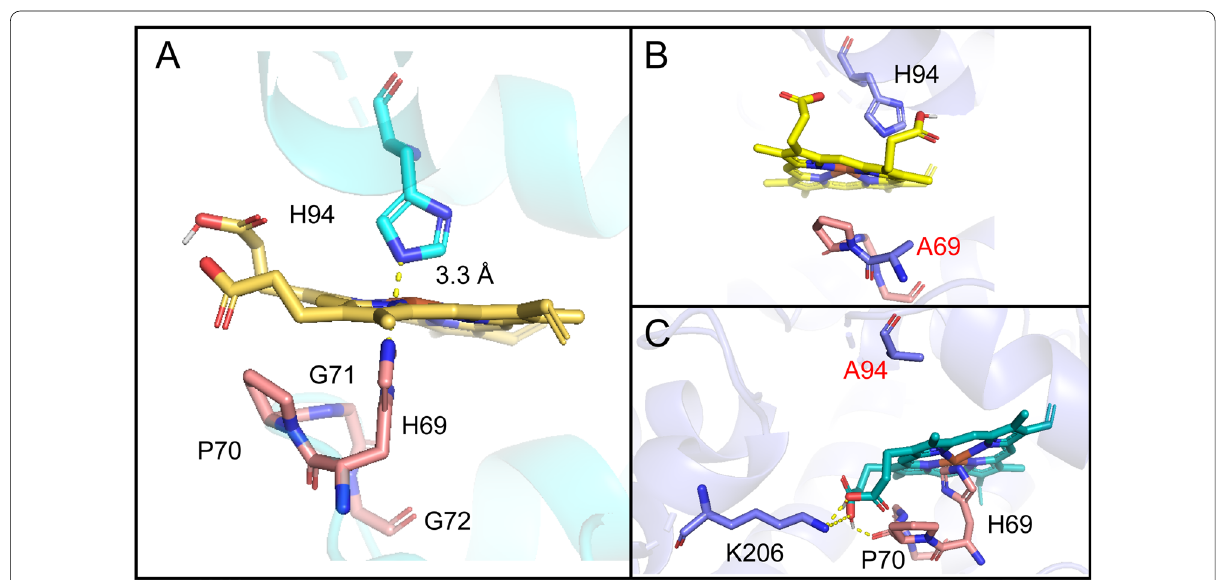
Fig. 4 Key binding sites of Mp FADS6 to heme ( A ). Conformational changes in Mp FADS6 due to mutations H94A ( B ) and H69A ( C ). Yellow stick indicates heme with divalent iron in the center. The salmon stick indicates the Cyt b 5 -like domain at the N-terminus of Mp